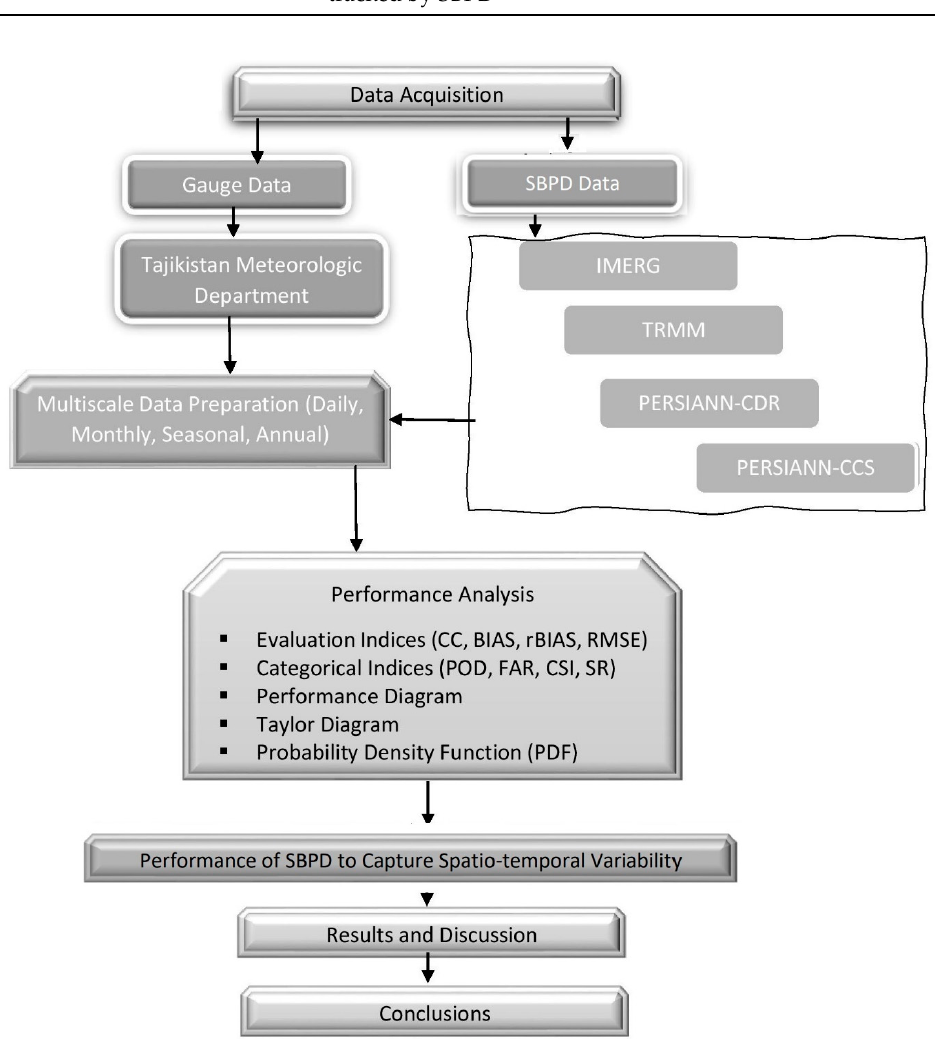
Figure 2. The layout of the whole analysis to assess the performance of SBPD. Table 3. The formulations of all evaluation and categorical indices used in performance evaluation.